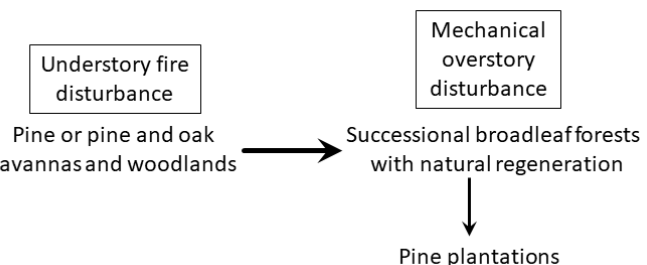
Figure 3. Change of disturbance type and disturbance-dependent forests, from fire-dependent pine or pine-oak forests to successional broadleaf forests, which subsequently were converted to pine plantations.